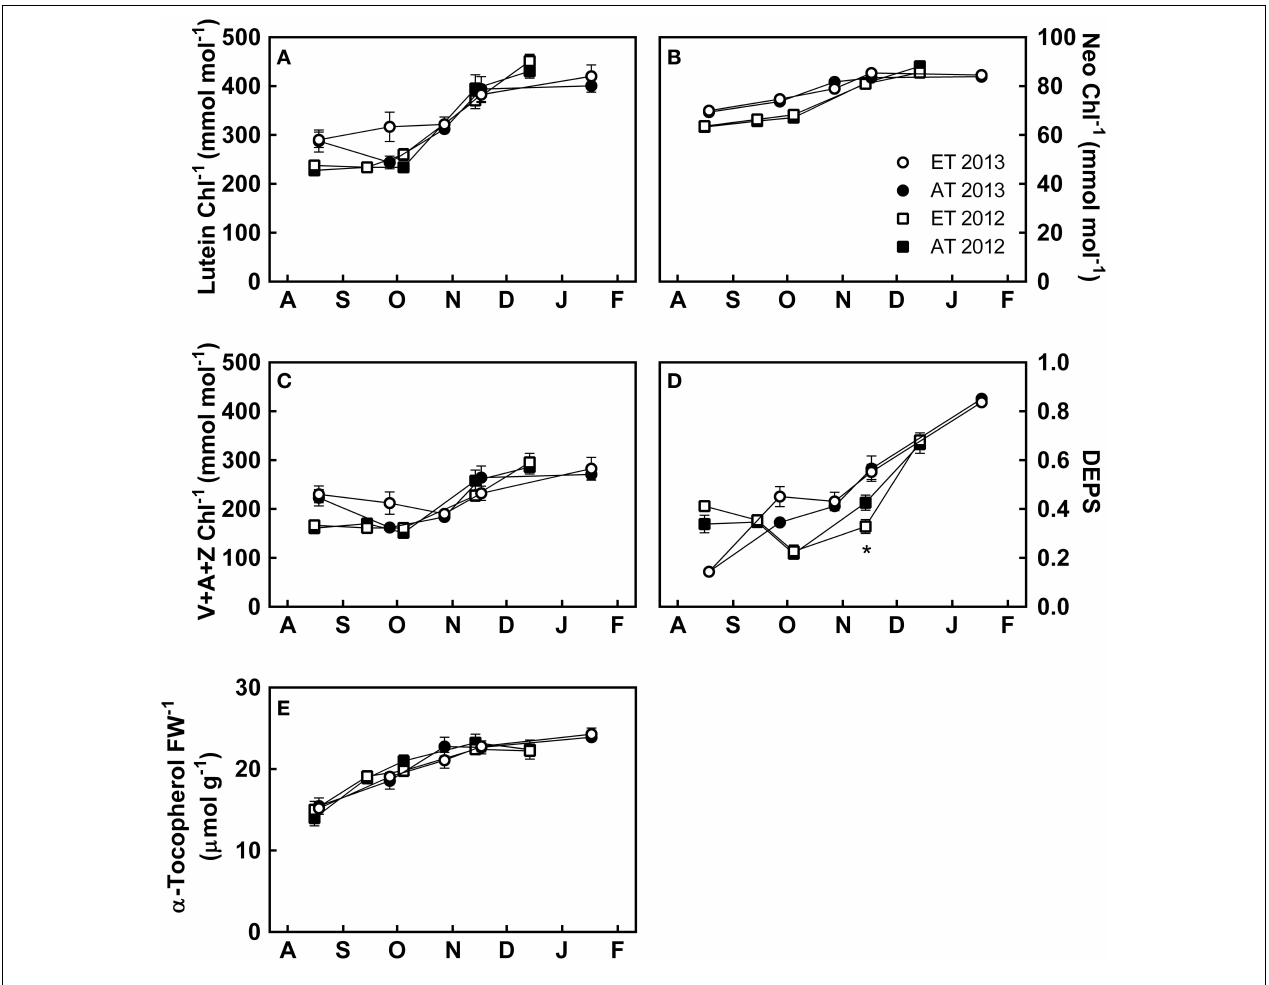
FIGURE 6 | Effect of elevated temperature on photoprotective metabolites in needles of field-grown white pine seedlings during autumn. (A) Lutein per total chlorophyll; (B) neoxanthin per total chlorophyll; (C) xanthophyll pool size per total chlorophyll; (D) de-epoxidation state